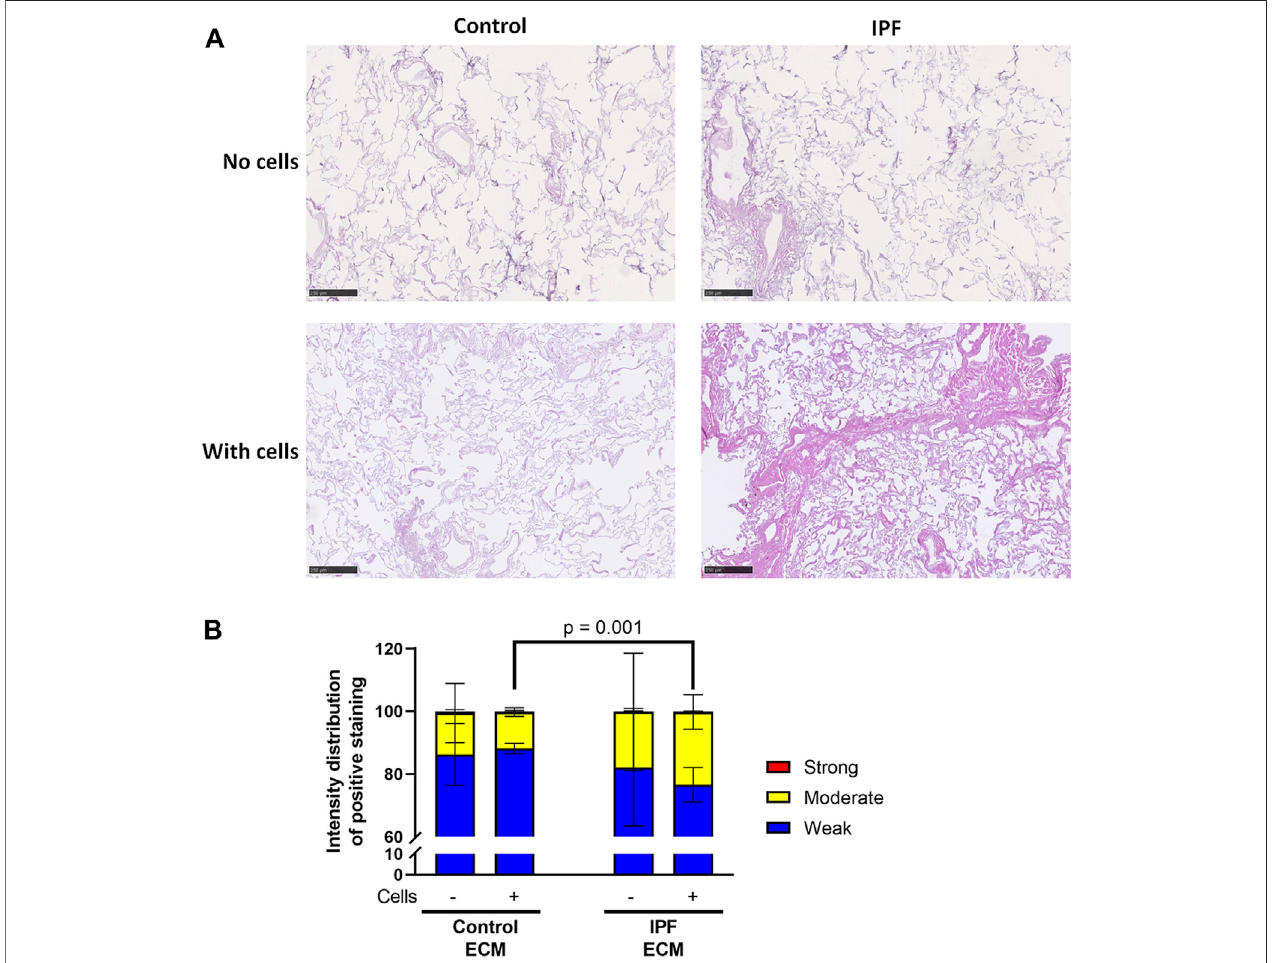
FIGURE 3 | More ECM deposition in IPF matrices upon recellularization compared to control matrices. Primary lung fi broblasts were seeded into decellularized matrices and cultured for 7 days. Sections of recellularized lung tissue were stained with haematoxylin (blue) and eosin (pink). (A) Representative images of the stained recellularizedmatrices,showingamagni fi edpartoftheimageofthetotaltissuesection.Scalebar (cid:2) 250 μ m. (B) Quanti fi cationoftheintensitydistributionofthestaining. Groups were compared using a two-way ANOVA followed by the original FDR method of Benjamin and Hochberg post hoc test. p < 0.05 was considered signi fi cant. All matrices are derived from the same control and IPF donor, primary lung fi broblasts were obtained from three different control donors.